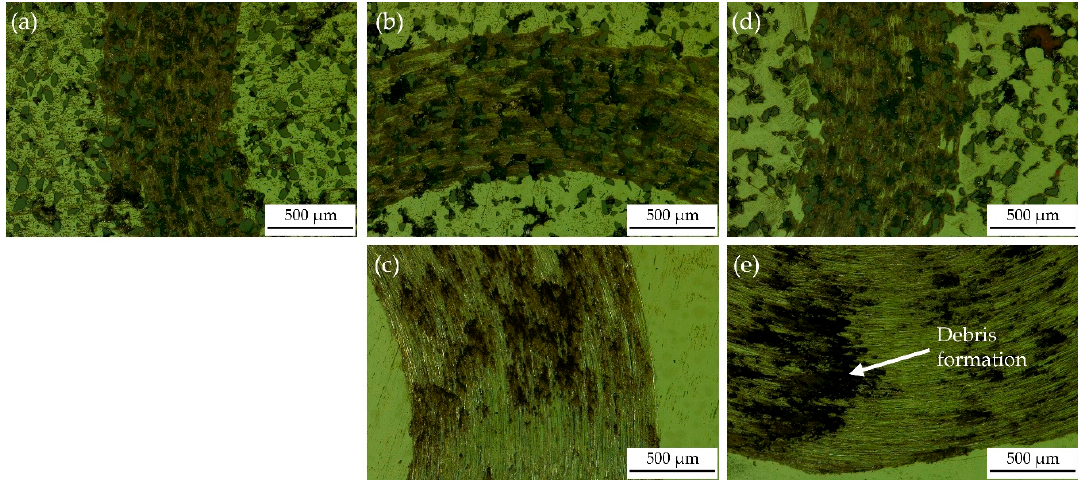
Figure 11. Worn surface: ( a ) Ti + 30 vol. % B 4 C, ( b ) Ti + 30 vol. % B 4 C + 20 vol. % Ti-Al(1), ( c ) Ti + 20 vol. % Ti-Al(1), ( d ) Ti + 30 vol. % B 4 C + 20 vol. % Ti-Al(2) and ( e ) Ti + 20 vol. % Ti-Al(2).